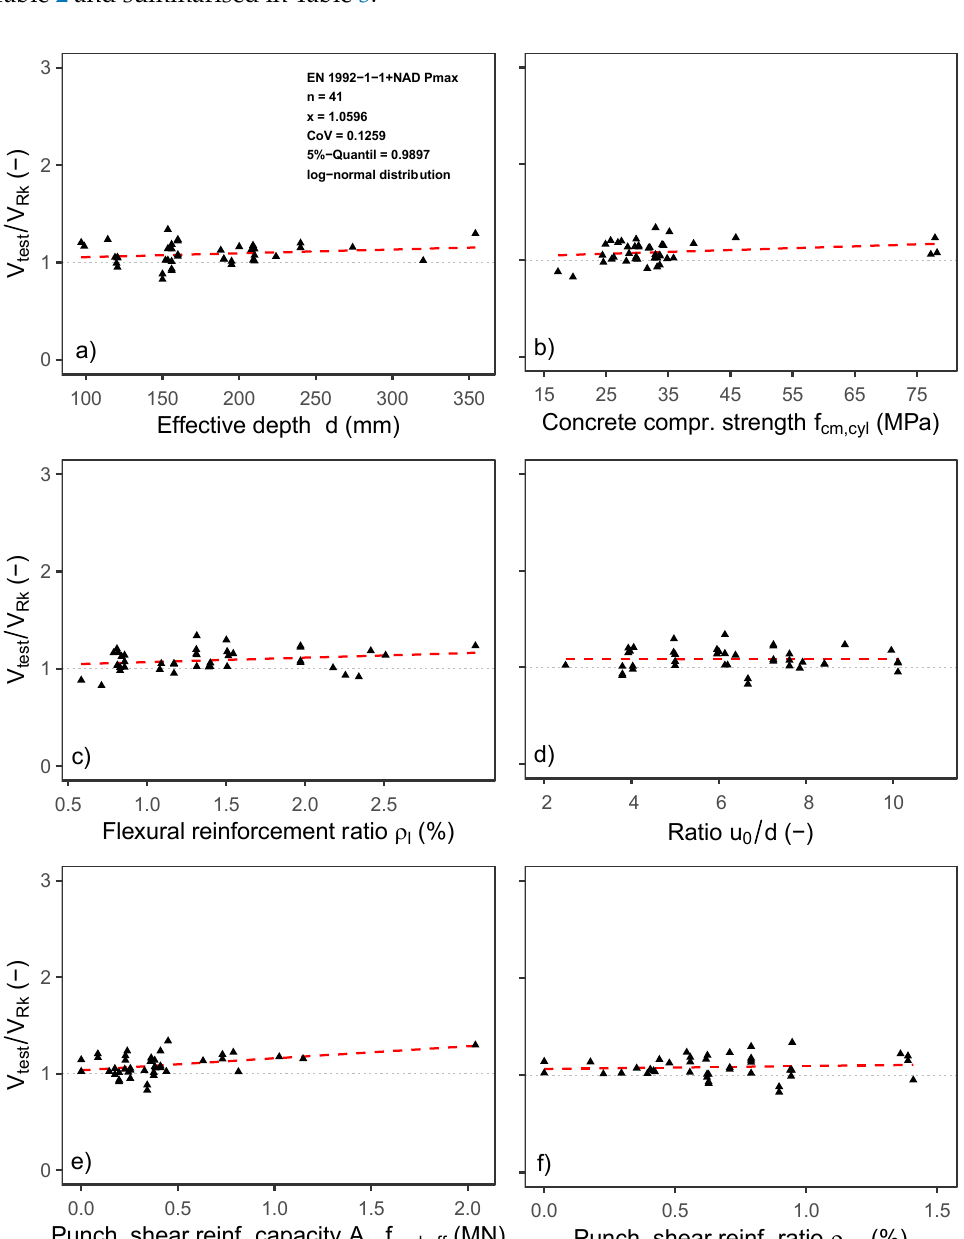
Figure 3. Model uncertainties at the maximum punching shear capacity (i.e., failure mode (iii) described in Section 1) according to DIN EN 1992-1-1+NA(D) [4–7] with f ck = f cm,cyl as a function of the ( a ) effective depth d (mm), ( b ) concrete compressive strength (cylinder) f cm,cyl (MPa), ( c ) flexural reinforcement ratio ρ l (%), ( d ) ratio u 0 / d (–), ( e ) punching shear reinforcement capacity A sw · f ymw,eff (MN) and ( f ) punching shear reinforcement ratio ρ sw